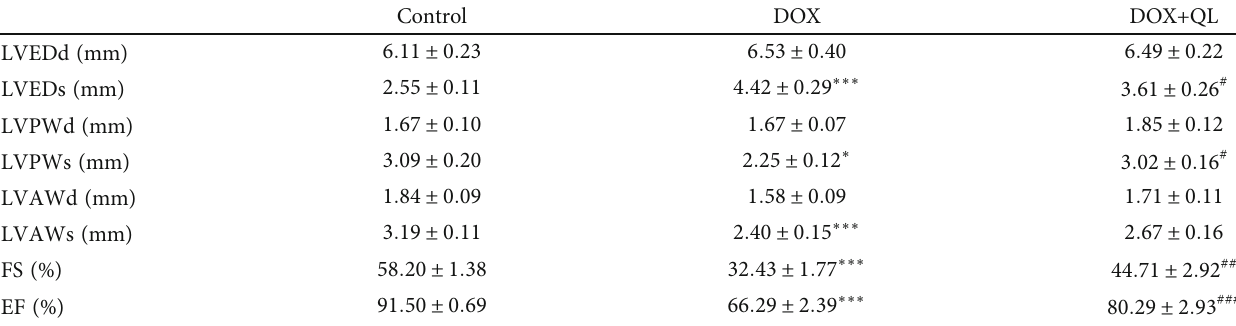
Table 1: Left ventricular functional parameters of rats on 31st